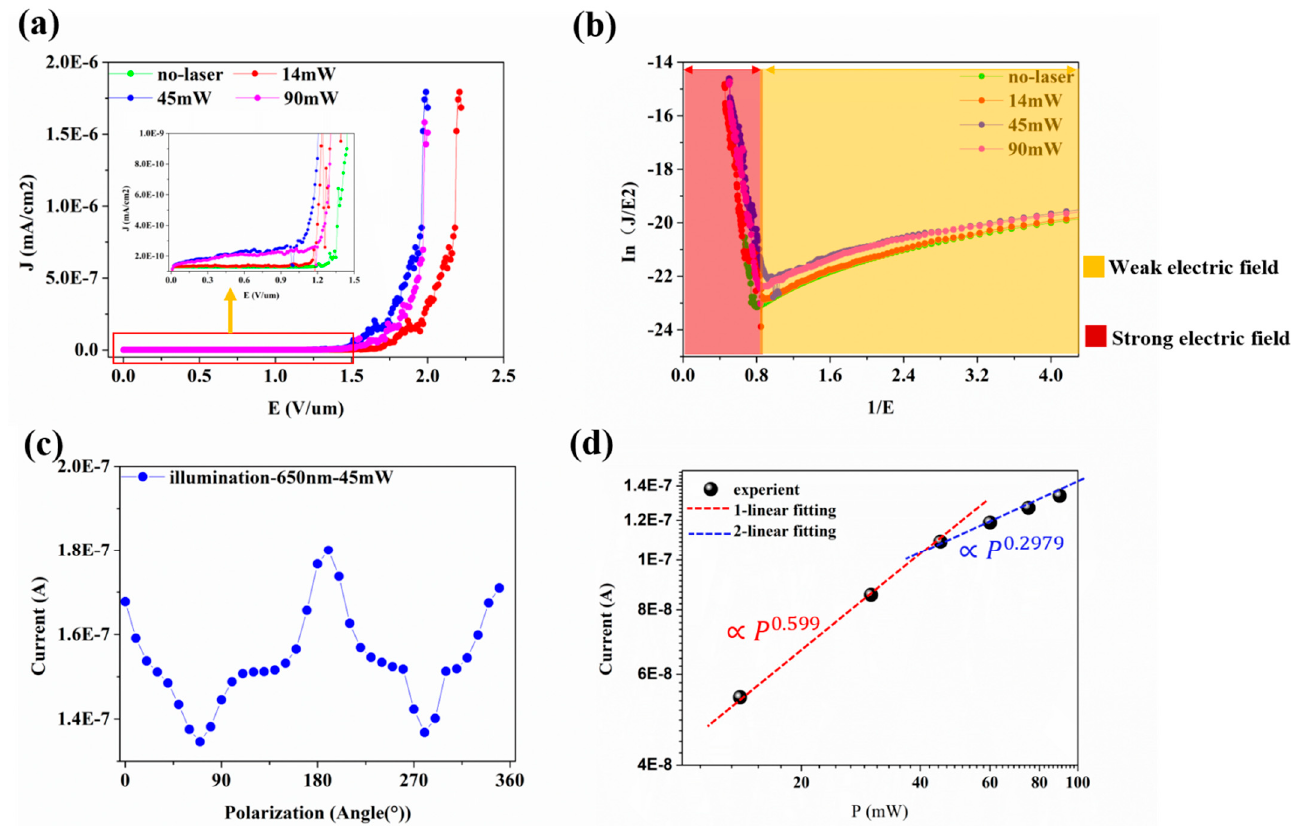
Figure 3. ( a ) J-E curves for an excitation laser wavelength of 650 nm at selected average values of the input laser power. The inset is enlarged for the y-axis values between 0 to ~1 × 10 − 9 mA/cm 2 ; ( b ) The Fowler-Nordheim (F–N) plots. ( c ), Photocurrent curves dependent on the incident light polarization, given at a 300 V bias voltage and the 14 mW laser power for 650 nm excitation. ( d ) I-P curves at selected bias voltages for 650 nm excitation. The dotted lines represent the fitting curves.